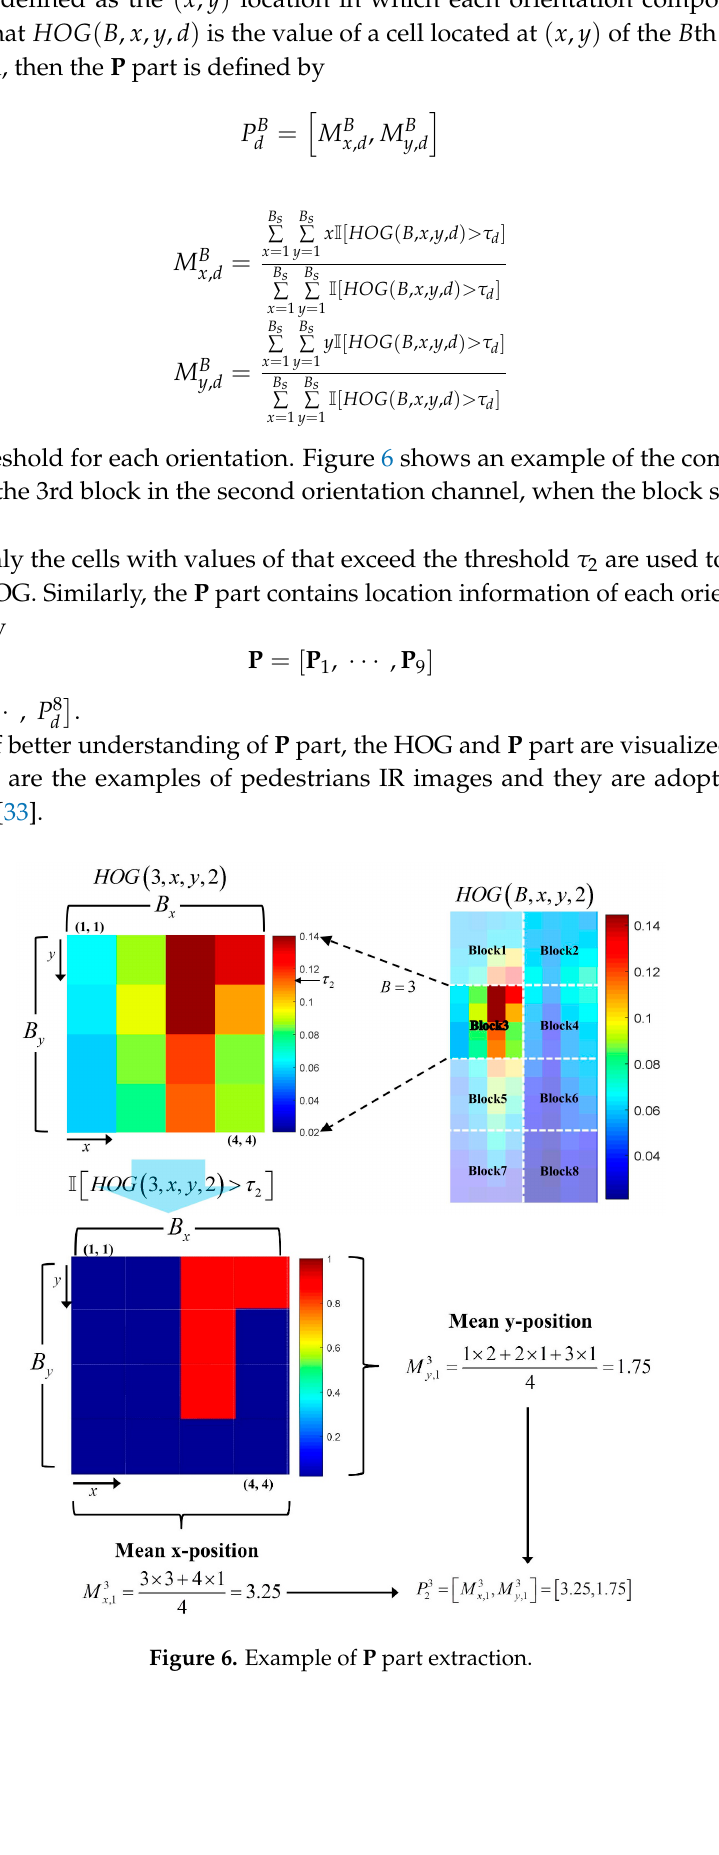
Figure 7. Examples of pedestrian IR images in KAIST pedestrian dataset [33]. Figure 8. Average gradient channels of HOG for pedestrians.